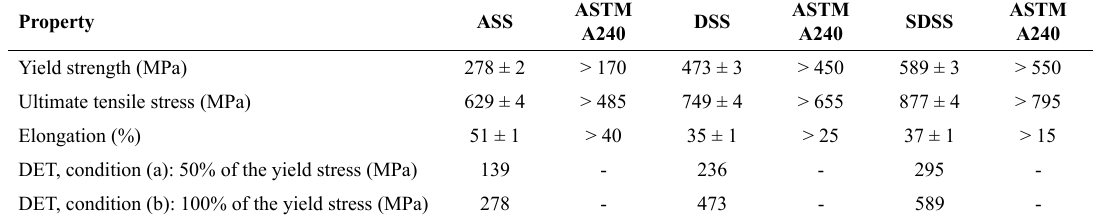
Table 3. Mechanical properties of UNS S31603 ASS, UNS S32205 DSS and UNS S32750 SDSS at room temperature and the values of maximum tensile stress used for DET for conditions (a) and (b).